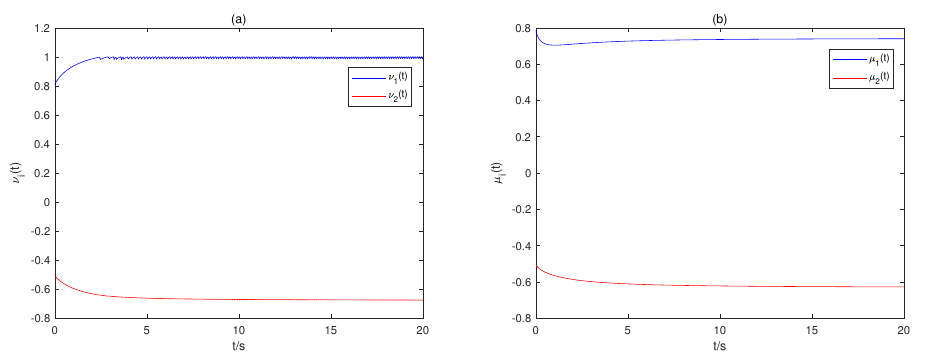
Figure 1. ( a ) Time responses of ν 1 ( t ) , ν 2 ( t ) ; ( b ) µ 1 ( t ) , µ 2 ( t ) . In view of Theorem 1, the quasi-synchronization can be achieved for systems (1)–(2) = 0.3776, which is verified by Figure 2. From in the presence of error bound (cid:107) ε ( t ) (cid:107) 1 ≤ θ λ Figure 3, one can conclude that the synchronization error can be influenced by ∆ T .